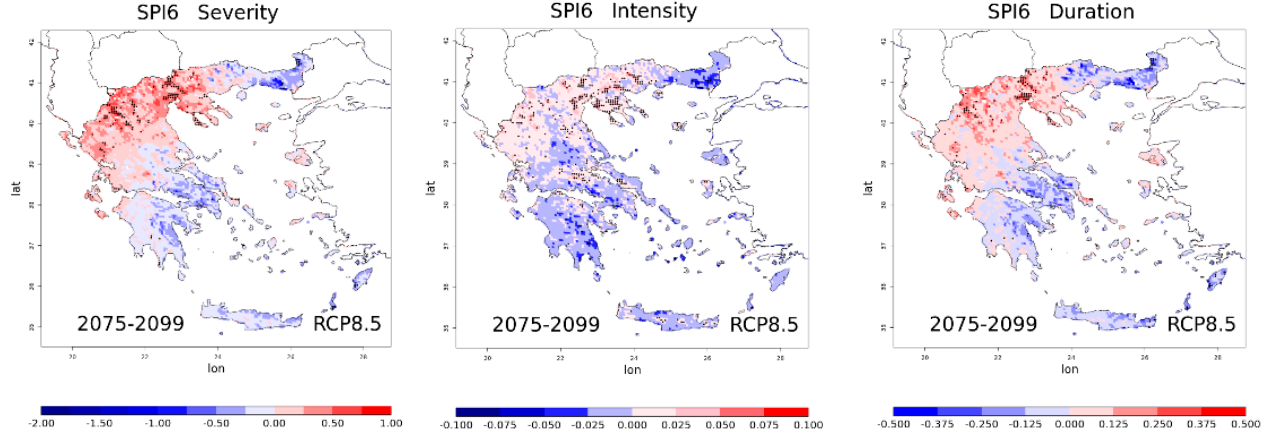
Figure 7. Trends of Severity ( left ), Intensity ( center ) and Duration ( right ) for the 6-month SPI under RCP4.5 and RCP8.5 for the period 2025–2049 and 2075–2099. The black dotted areas show significant changes in the drought characteristics at the 5% significance level.